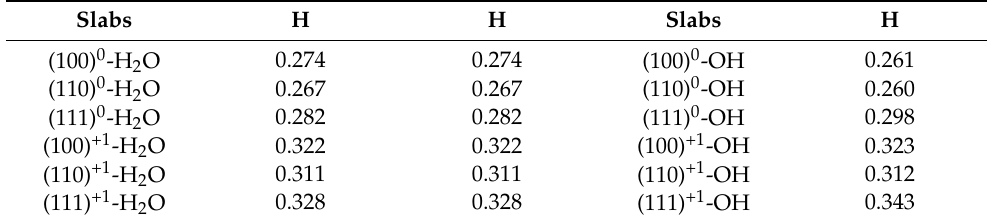
Table 5. The charges of the two H of adsorbed H 2 O; the charges of the H of adsorbed OH.